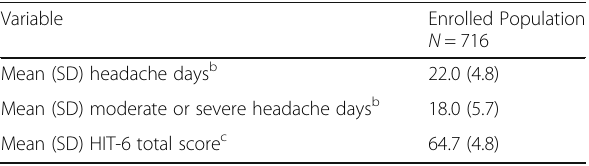
Figure S1), as did the subgroup not on oral preventive treat-